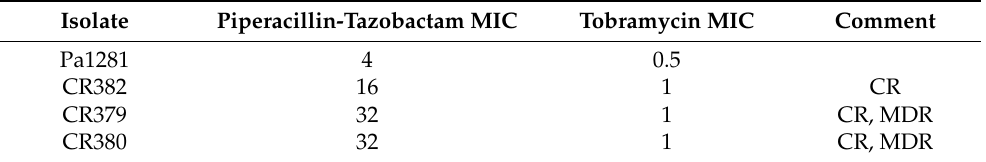
Table 1. Minimum inhibitory concentrations (MIC, mg/L) of P. aeruginosa isolates for piperacillin- tazobactam and tobramycin. Isolate Piperacillin-Tazobactam MIC Tobramycin MIC